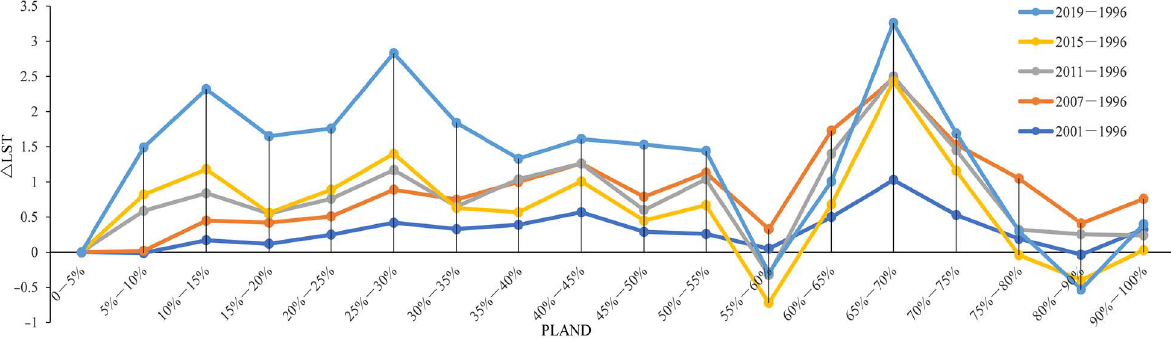
Figure 12. Statistics of the average temperature of different percentage of built-up land (PLAND) types.